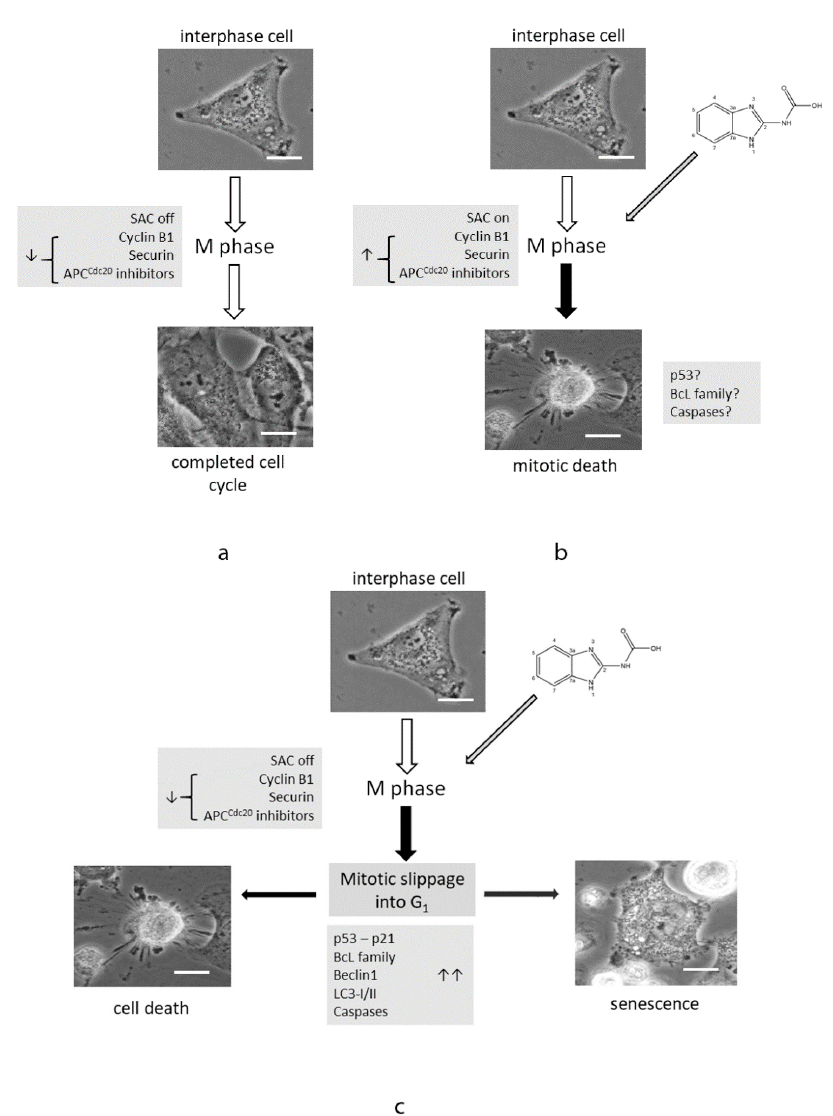
Figure 1. Modes of glioblastoma (GBM) cells responses to benzimidazole carbamates. ( a ) During